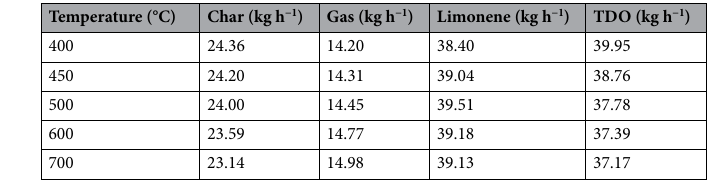
Table 4. Results of this simulation at different temperatures for tire pyrolysis products.